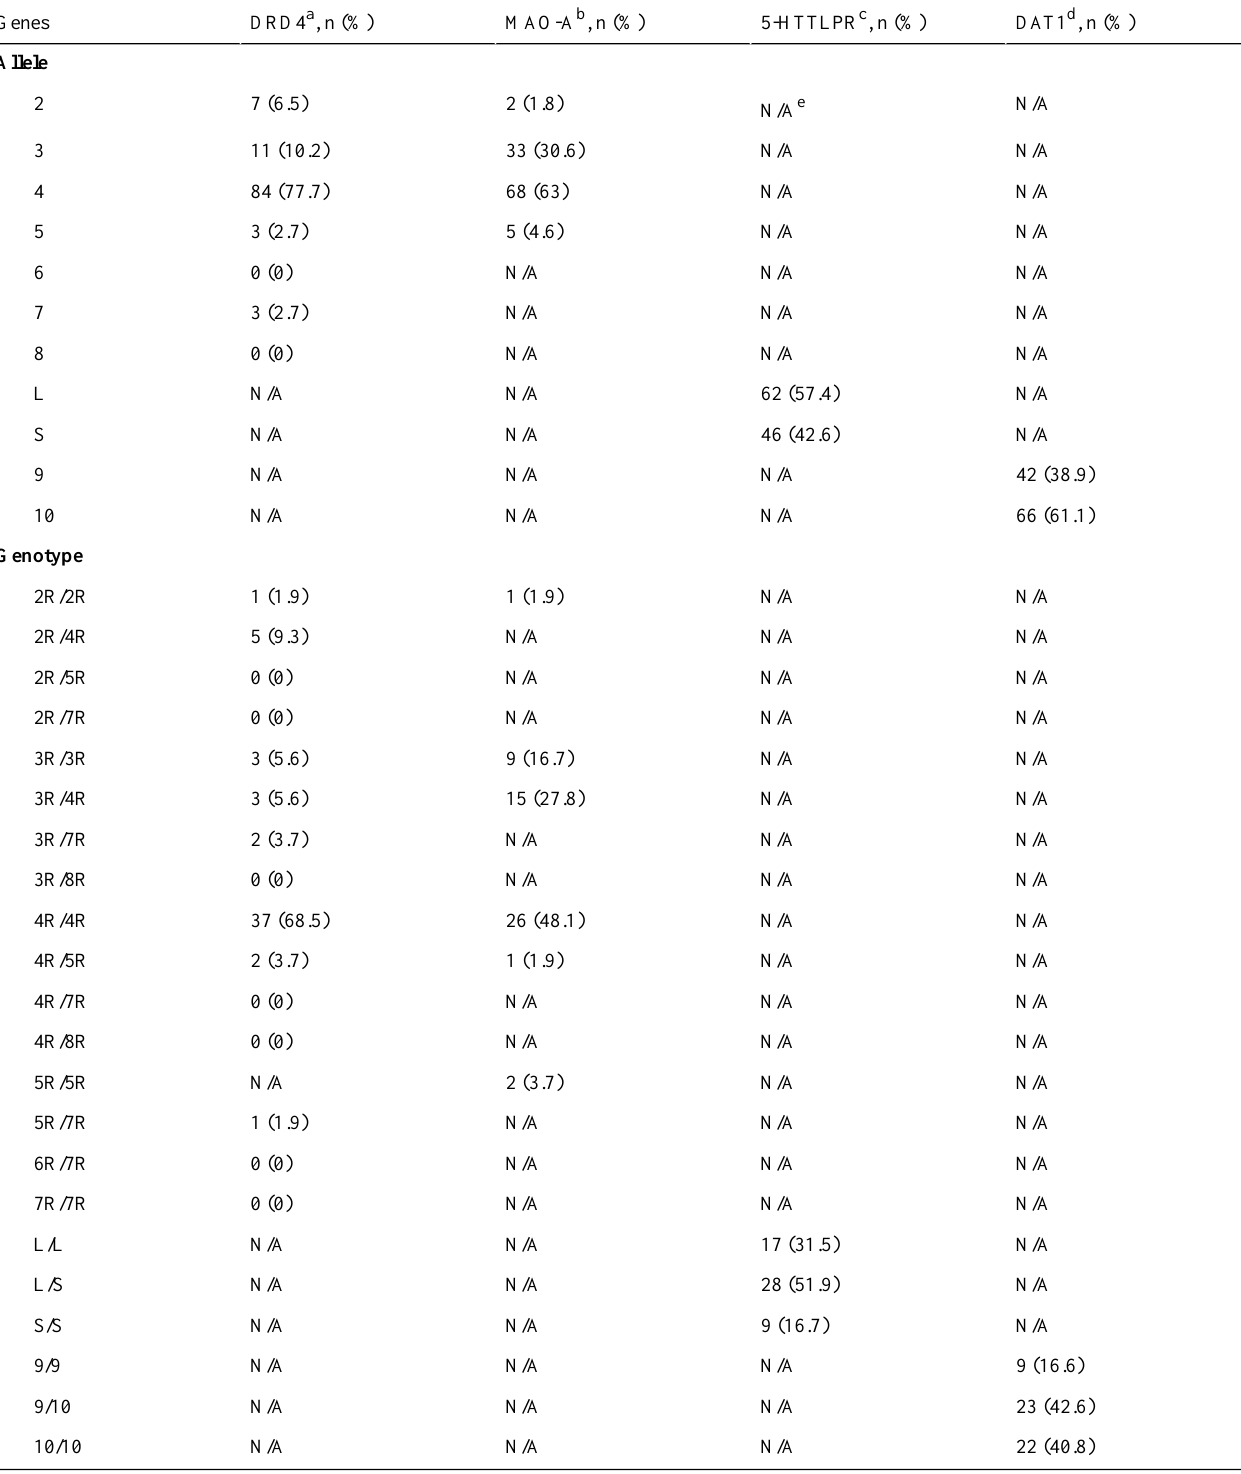
Table 2. Allele and genotype frequencies of the dopamine D4 receptor, monoamine oxidase A, serotonin-transporter, and dopamine active transporter 1 genes among